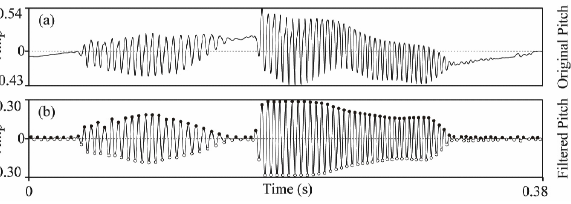
Figure 4: Preliminary processing of throat microphone signal. (a) Source signal. (b) The result of filtering and searching for local ex- tremes (black points - local maxima ( w 0 , w 1 , ..., w C local minima).